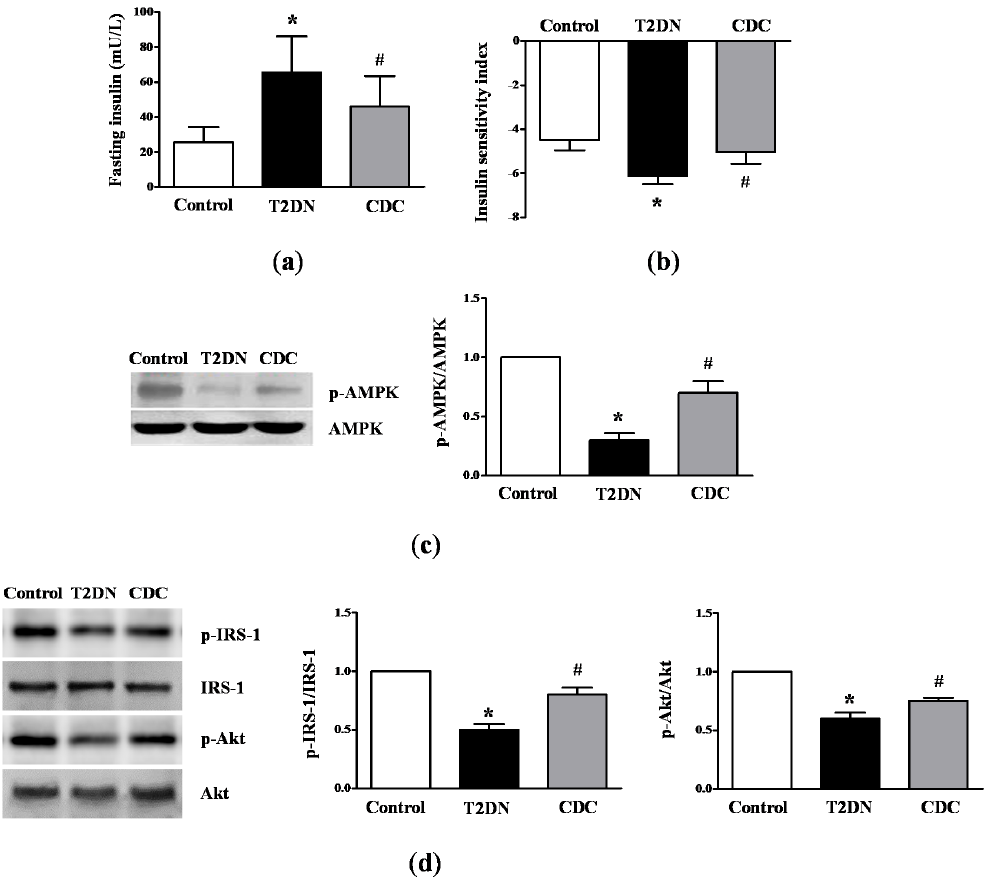
Figure 3. Effect of 12-LO on IR-related parameters in type-2 diabetic rats. ( a ) Fasting insulin levels were determined by radioimmunoassay (RIA); ( b ) ISI was measured as 1/(fasting insulin × fasting glucose); ( c ) AMPK expression in skeletal muscle was determined by Western blot; n = 20 in each